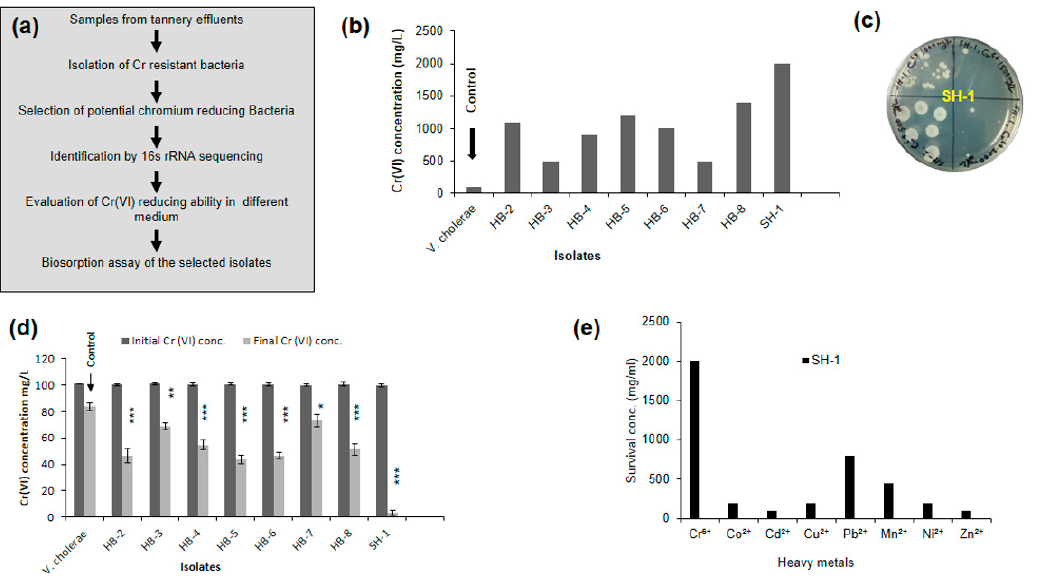
Figure 1. Screening of Cr(VI) reducing bacteria from tannery effluent. ( a ) Schematic diagram of Cr(VI) resistant organism isolation from tannery effluent. ( b ) The resistance of the isolates at different concentrations of Cr(VI). ( c ) Representative growth plate of SH-1 isolate (Top image) from Cr(VI) resistance experiment. ( d ) Reduction of Cr(VI) by the isolates in Luria–Bertani (LB) broth with an initial concentration of 100 mg/L after 72 h of incubation at 37 °C. One way ANOVA followed by Tukey’s post-hoc test was performed to find statistical significance. “*”denotes significant difference between negative control ( V. cholerae ) and other isolates (* p <0.05, ** p < 0.01, *** p < 0.001). ( e ) Resistance to different heavy metals (This experiment was done once).